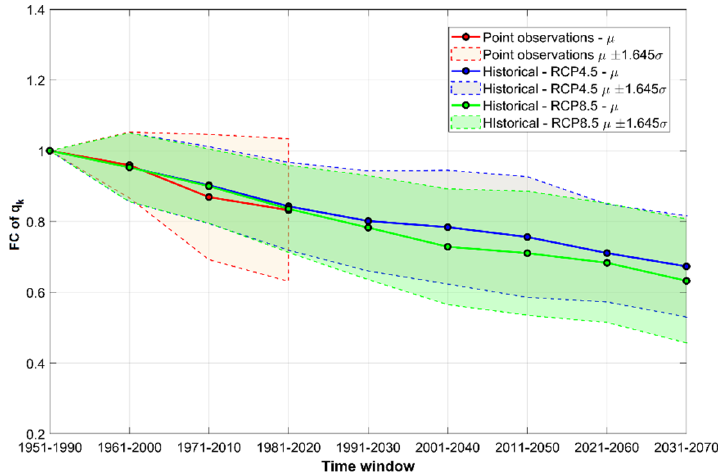
Figure 9. FC of characteristic values of ground snow load q k , associated to 0.02 probability of exceedance in one year, for the investigated weather stations. Average value µ and confidence interval µ ± 1.645 σ are shown according to point observations (in red) and regional climate model projections depending on the scenario RCP4.5 (in blue) and RCP8.5 (in green).